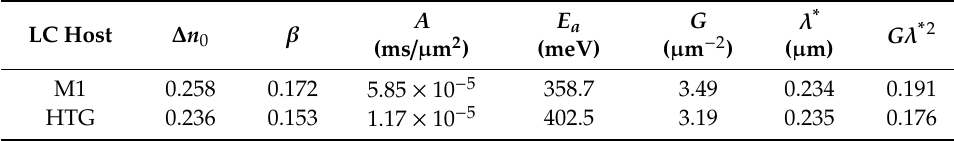
Figure 2. Temperature-dependent visco-elastic constant of M1 and HTG. Dots are measured data and solid lines are fitting curves with Equation (3). The fitting parameters are listed in Table 2.